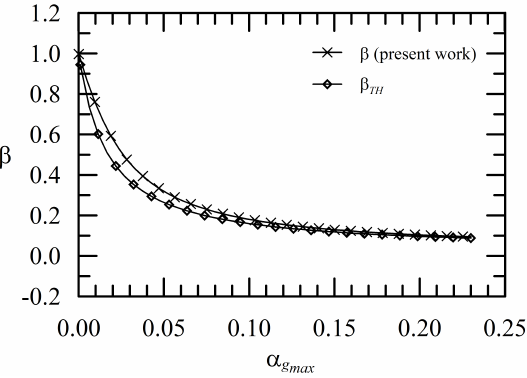
Figure 1 - Behaviour of β according to Eqs. (17) and